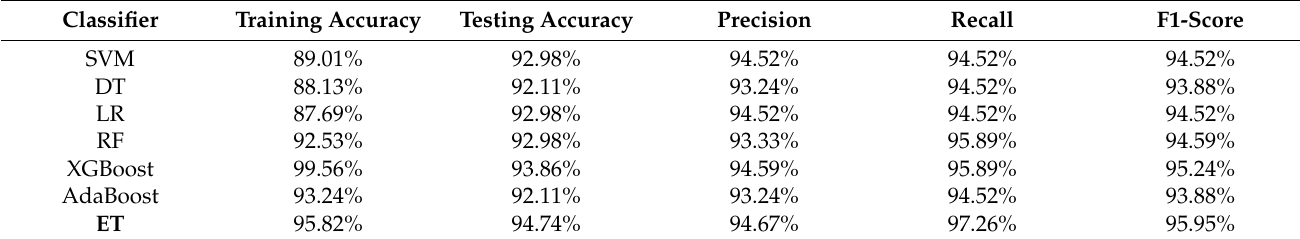
Table 4. The results of the proposed models using the ideal hyperparameters.